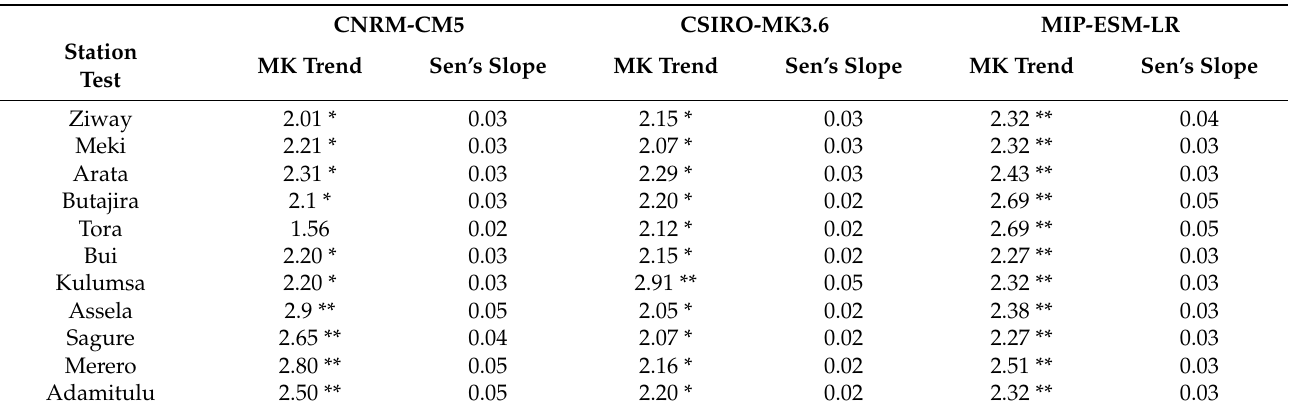
Table A3. Statistical indices values of GCMs–CMIP5 output monthly minimum temperature during 1983–2005 over Ziway Lake Basin.